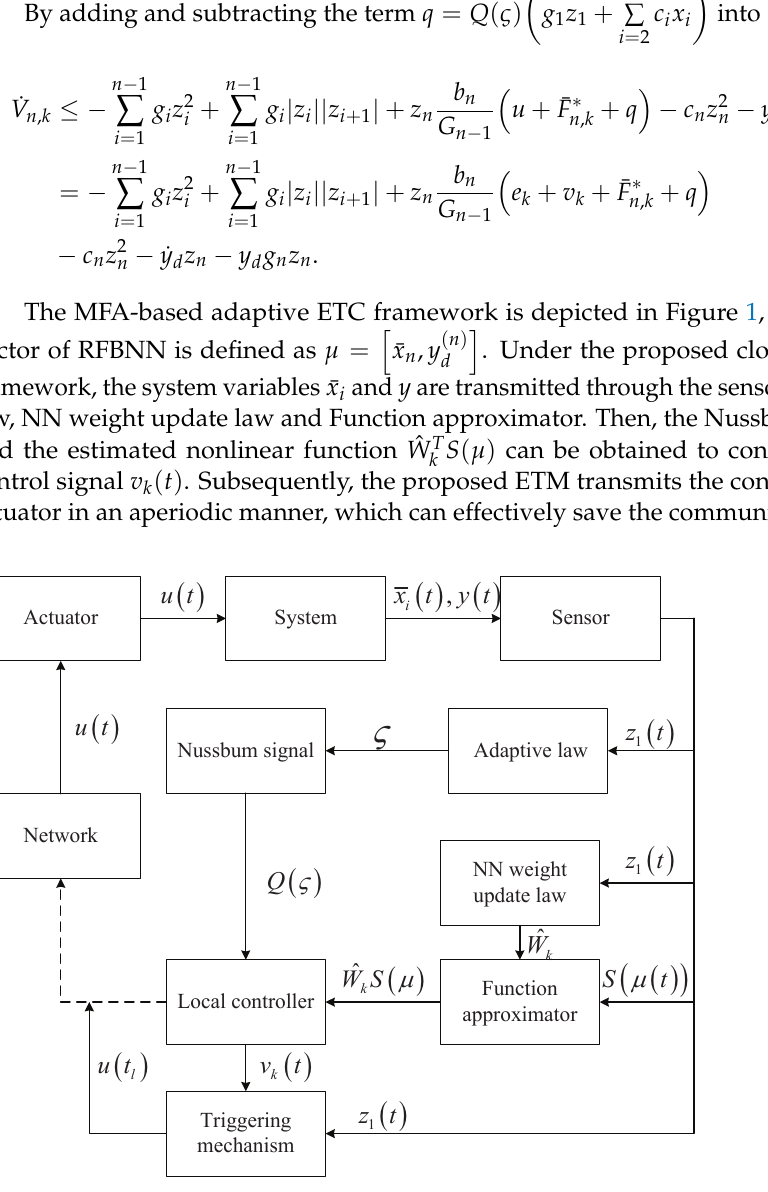
Figure 1. Minimal-function-approximation-based adaptive ETC